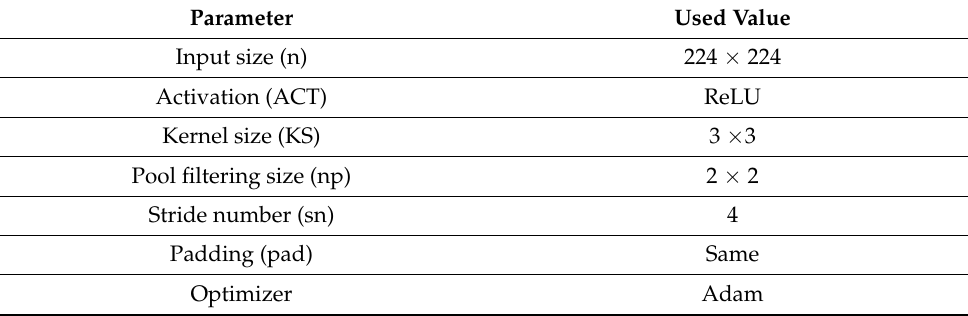
Table 2. The hyperparameters of VGG-19.